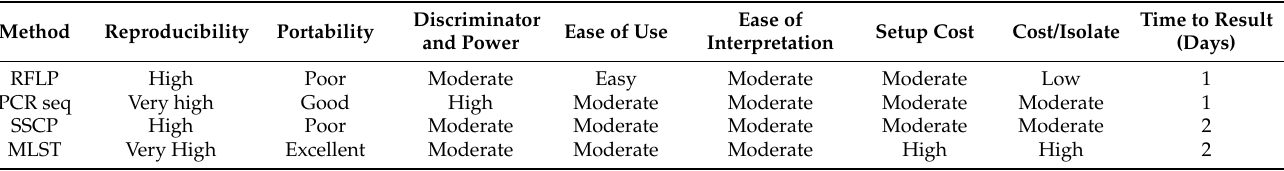
Table 2. Characteristics of different typing methods used for genotyping of DHPS in Pneumocystis jirovecii .